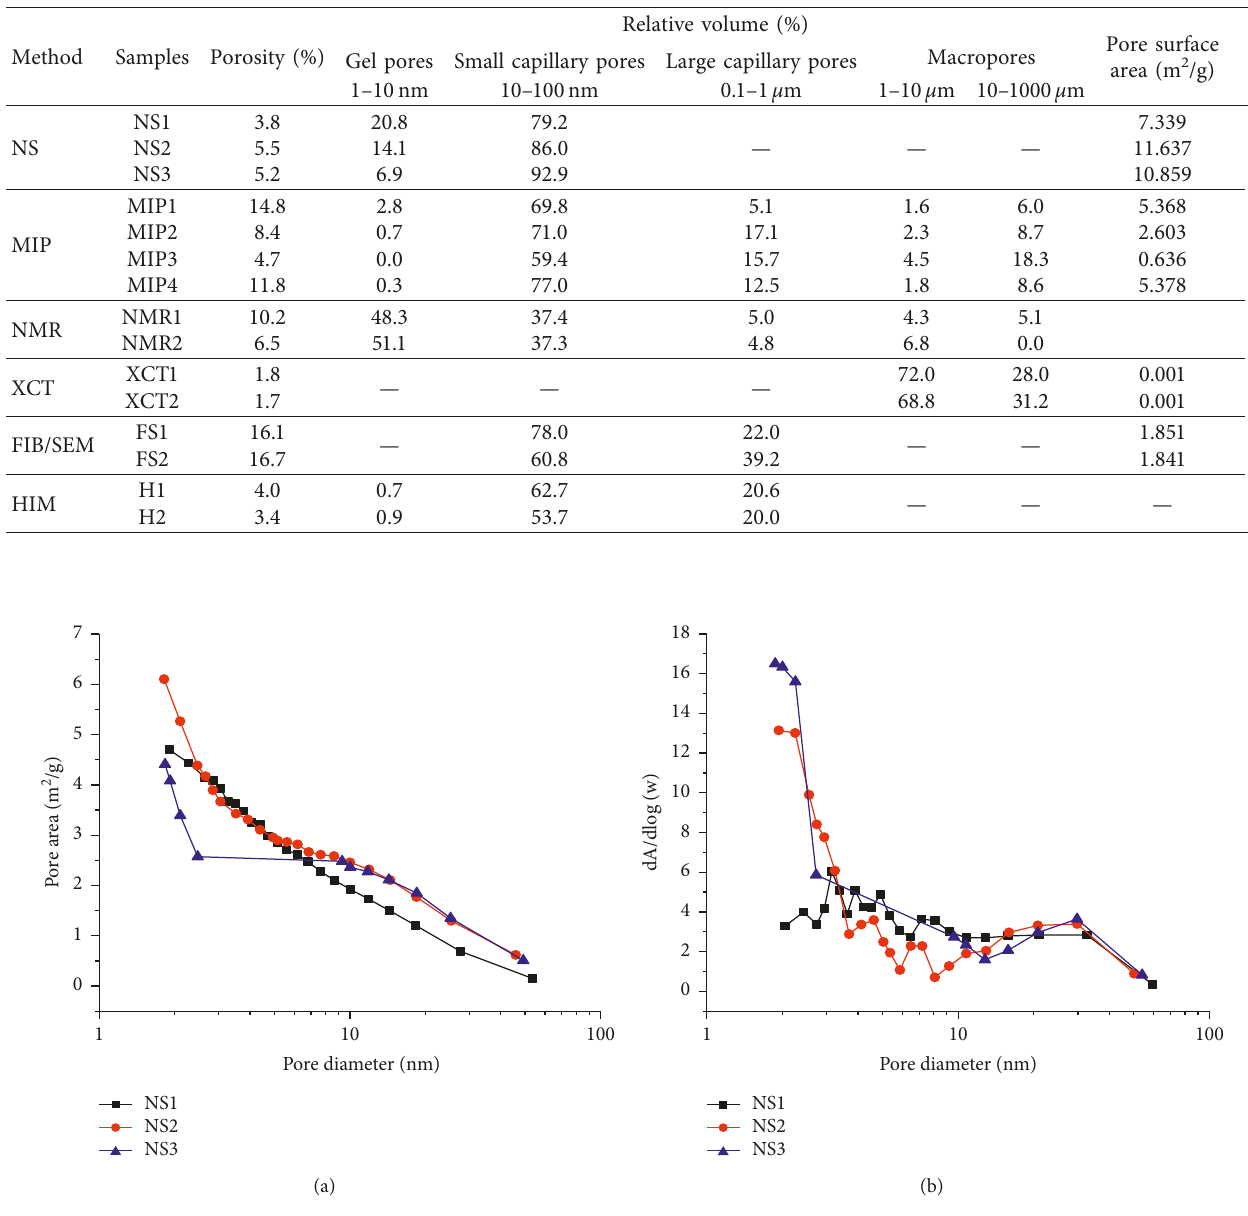
Table 3: Porosity and pore surface area of hardened cement paste.